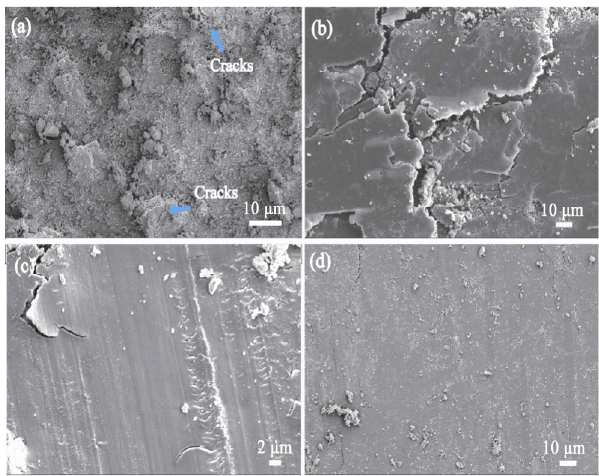
Fig. 6 Worn morphologies of LAS and C f /LAS composites with different carbon fiber content: (a) LAS glass-ceramics, (b) 33 vol% carbon fiber, (c) 37 vol% carbon fiber, and (d) 45 vol% carbon fiber.